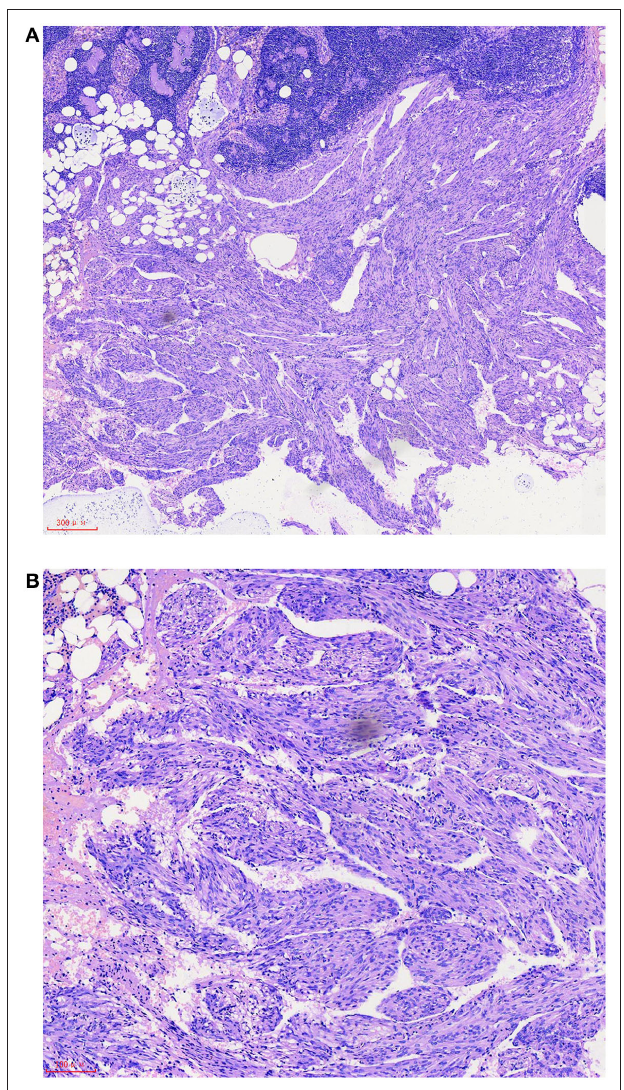
FIGURE 1 | After hematoxylin-eosin (HE) staining, it is found that there is a fascicular proliferative smooth muscle-like spindle cell area outside the pelvic lymph nodes, which has a clear boundary with the surrounding tissues (A). Smooth muscle-like spindle cell nuclei have no atypia and are mostly arranged around reticular or sinusoidal cavities lined with flat endothelium. Residual lymph nodes can be seen in local areas between proliferative spindle cells (B). The scale represents 300 µ m (A) and 100 µ m (B)